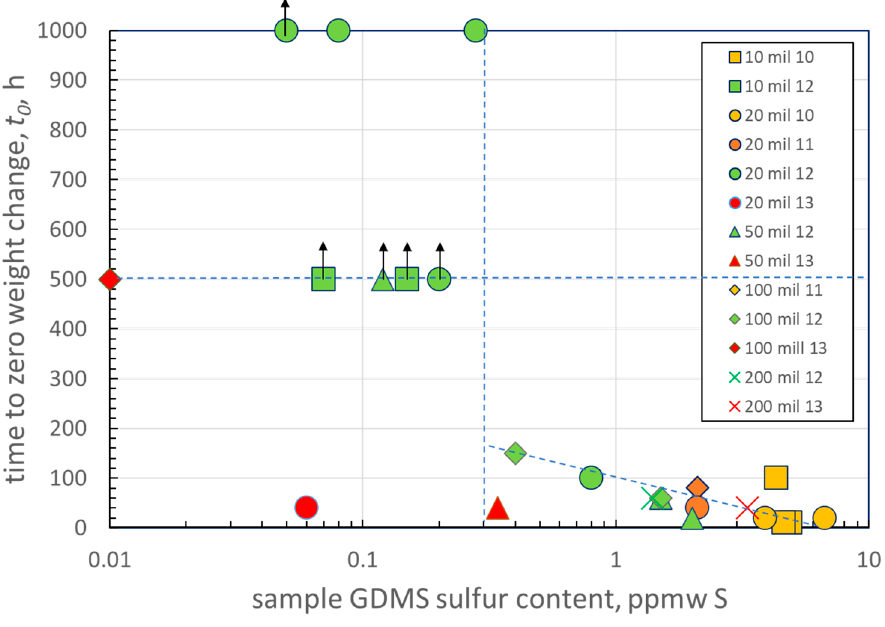
Figure 2. Cyclic oxidation performance scatter diagram for all PWA 1480 samples. The abrupt large increase in adhesion behavior ( t 0 , time to cross zero) for hydrogen-annealed samples having less than ~0.3 ppmw sulfur (1100 °C oxidation, up to 1000 h). Up arrows indicate t 0 condition not yet achieved. At higher sulfur levels, the overall trend indicates poor adhesion (lower t 0 ) with increasing sulfur content (symbols correspond to sample thickness, colors correspond to hydrogen anneal temperature: yellow 1000 °C, orange 1100 °C, green 1200 °C, red 1300 °C) .